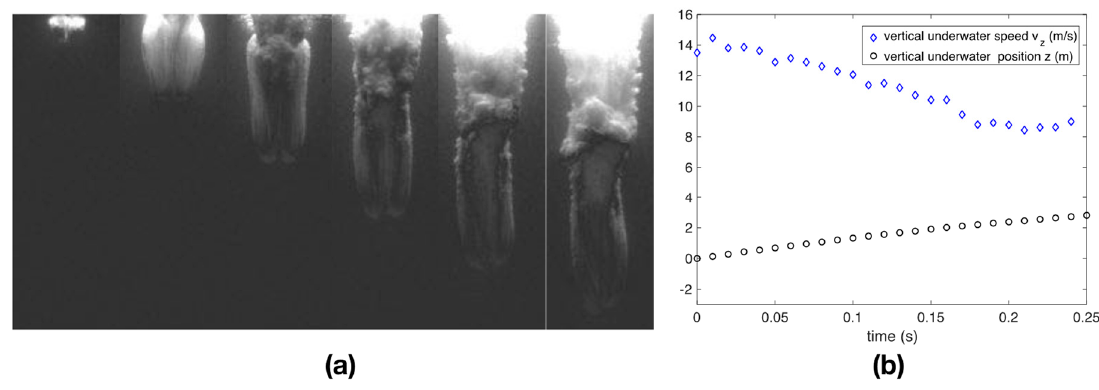
Figure 2. Trajectory of the diver’s center of mass in water for the same 10-m high dive: ( a ) Chronophotograph of the water entry. The timestep is 40 ms. ( b ) Time evolution of the downward vertical position (z) and speed (v z ) underwater. The origins of time and position are taken upon the feet impact on water for the underwater phase.